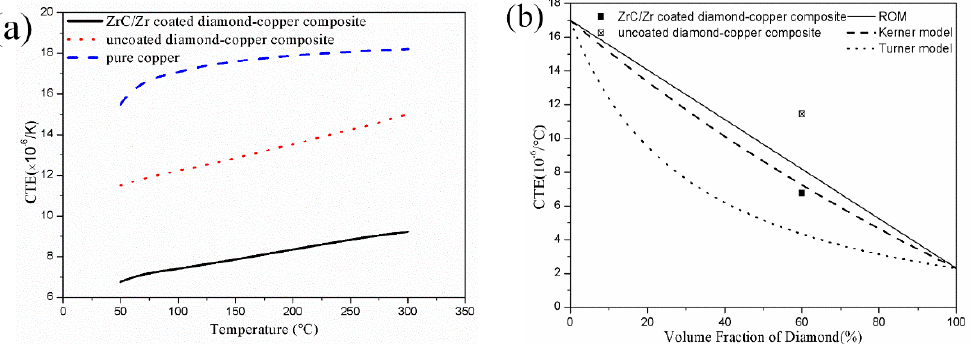
Figure 7. ( a ) Experimental CTE values of uncoated and ZrC/Zr-coated 60 vol. % diamond-copper composites; ( b ) Comparison of the CTEs between the experimental results and theoretical models.